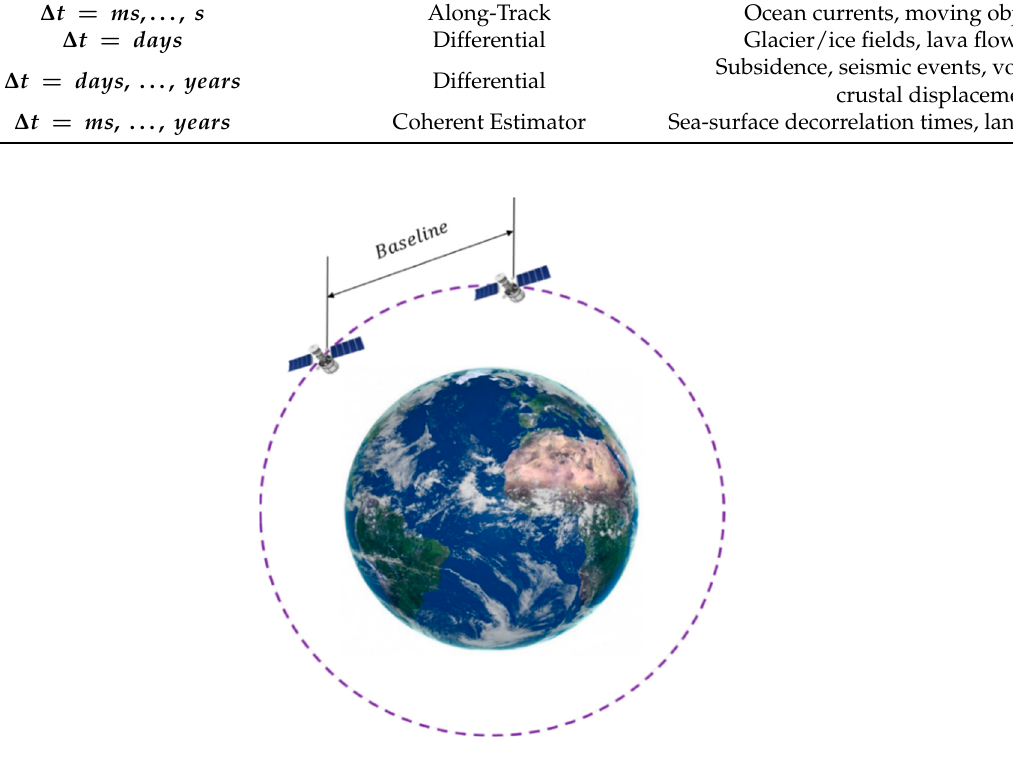
Figure 5. AT-InSAR baseline